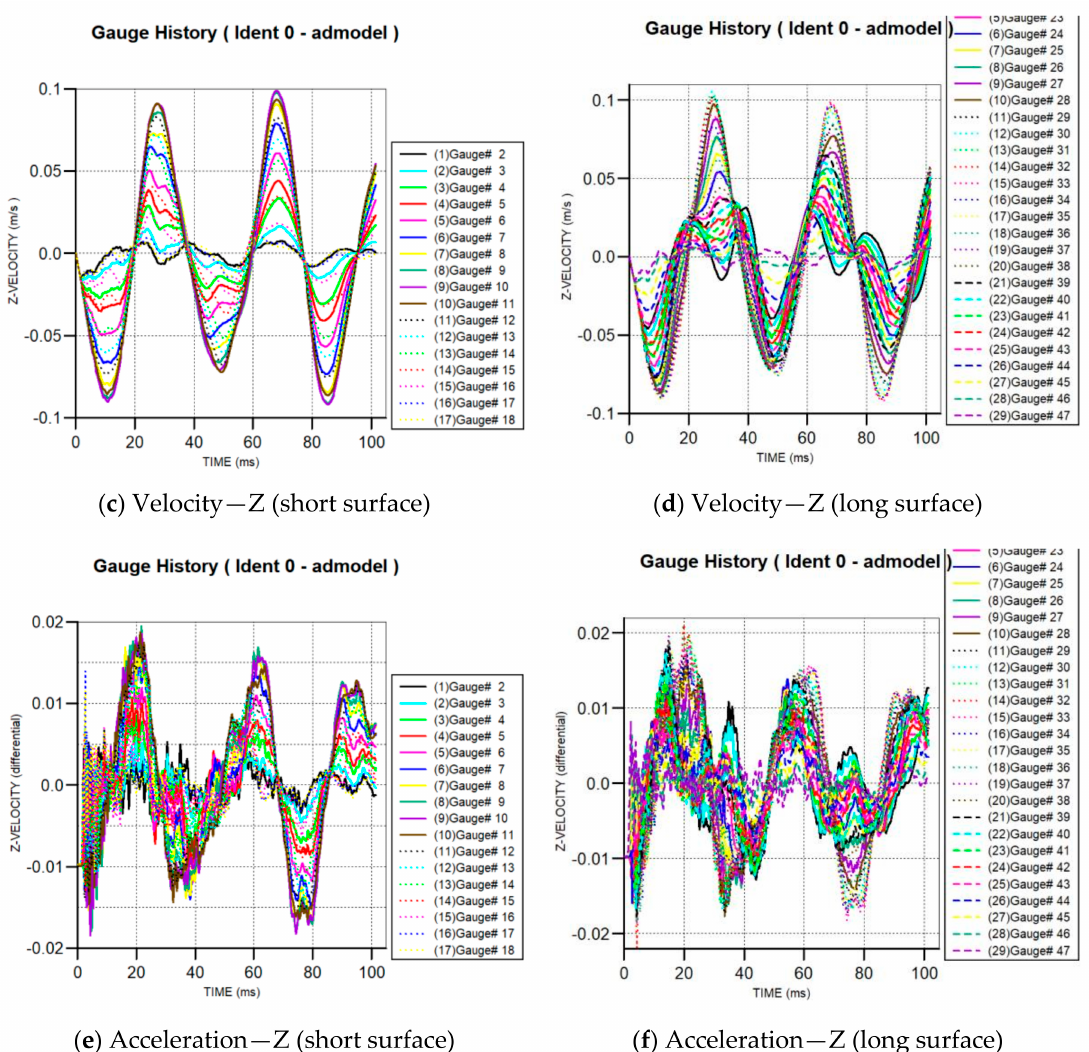
Figure 12. Displacement, velocity, and acceleration at certain sensors for Case 2.